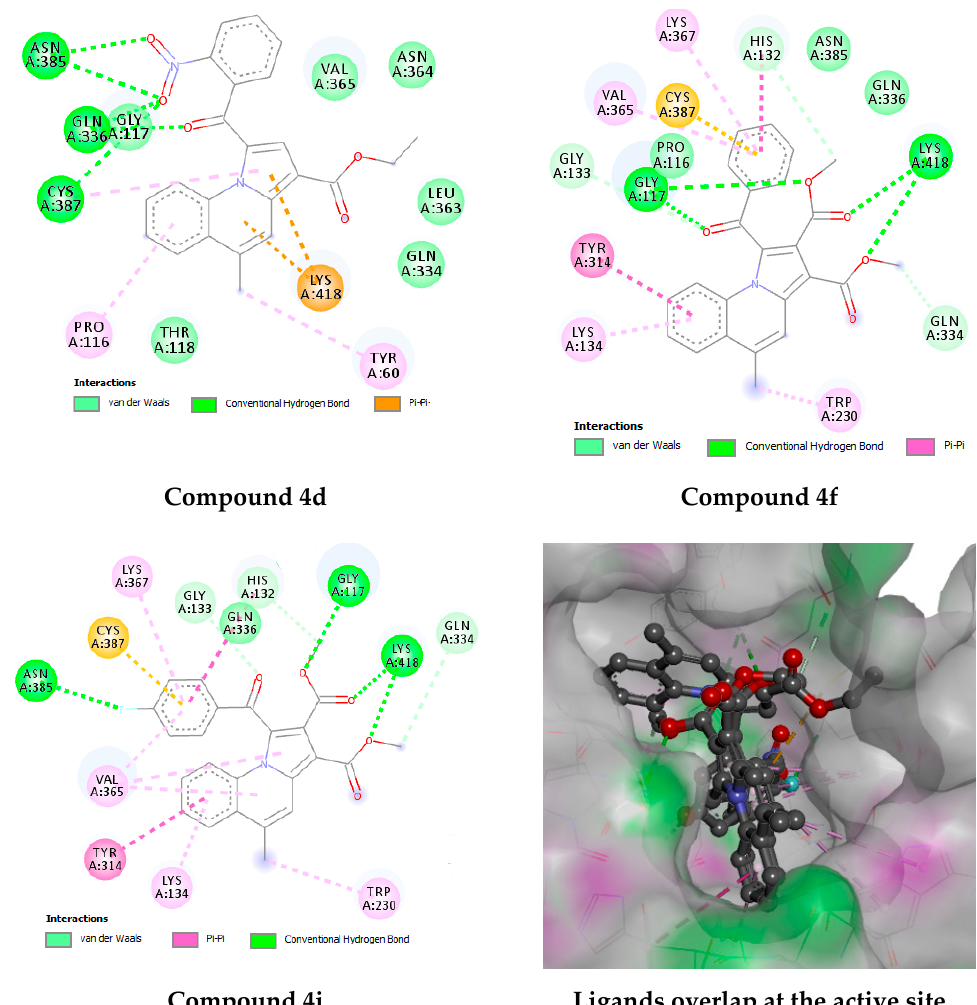
Figure 5. Intramolecular interactions of compounds 4d , 4f , and 4j with active site of DprE1 protein and their overlap at the active site. Table 3. Docking free energy (kcal/mol) and inhibition constant K i of target compounds 4a – k . Comp. Code